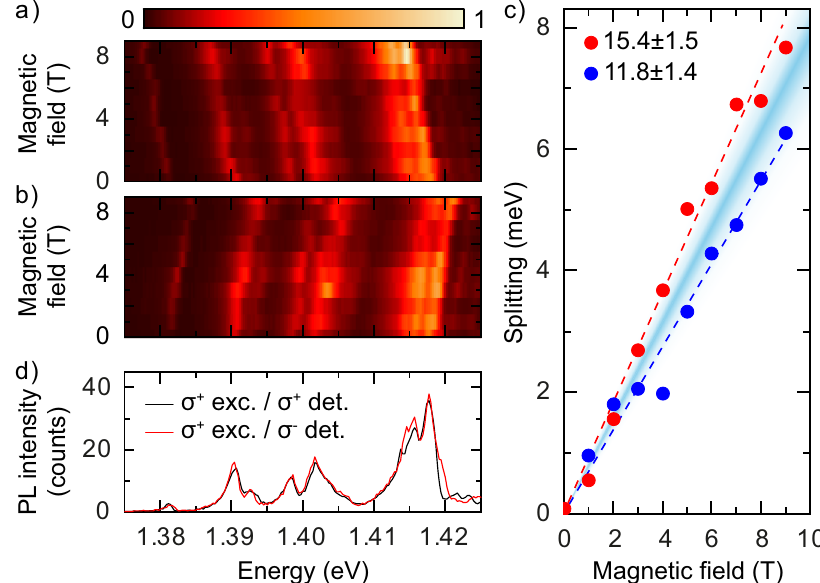
Fig. 3 Magnetic- fi eld dependence of con fi ned interlayer excitons. a Photoluminescence (PL) spectrum at 4 K as a function of magnetic fi eld B on a nanopillar under linearly polarised excitation and circularly polarised σ + detection. b Same measurement as a , but with σ − detection. The intensity of the components in a increases with B , and the blue-shifting components in b decrease with B , consistent with exciton thermalisation of Zeeman states at 4 K 63 . c Measured Zeeman splittings of con fi ned interlayer excitons as a function of B . The red (blue) circles correspond to con fi ned interlayer excitons with the largest (smallest) g-factor of 15.4 ± 1.5 (11.8 ± 1.4) extracted from the linear fi ts (dashed curves). The mean g-factor value of all measured splittings is 13.2 with a standard deviation 1.1. The error bars are smaller than the data points. d PL spectra of con fi ned interlayer excitons collected on the same nanopillar as a and b at 0 T for σ + excitation and co-polarised ( σ + ) and cross-polarised ( σ − ) detection, shown as black and red curves,